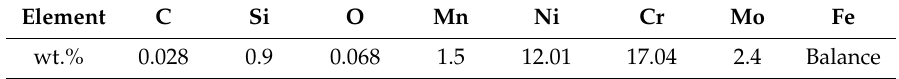
Table 1. Chemical composition of 316L stainless steel powder used in the study.